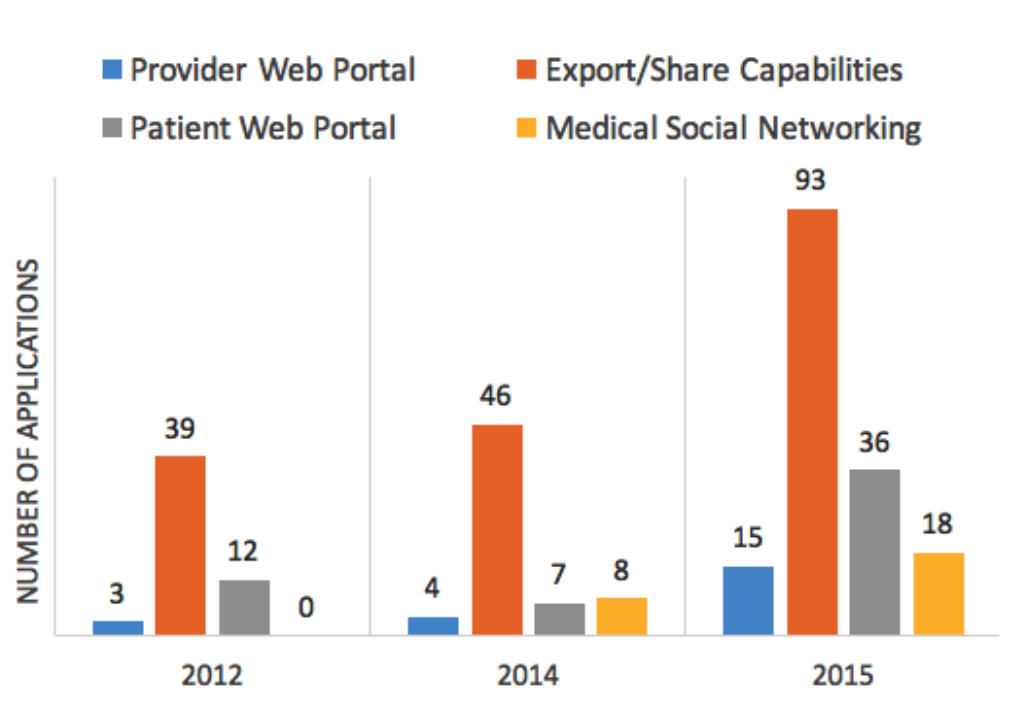
Figure 1. Changes in advanced connectivity